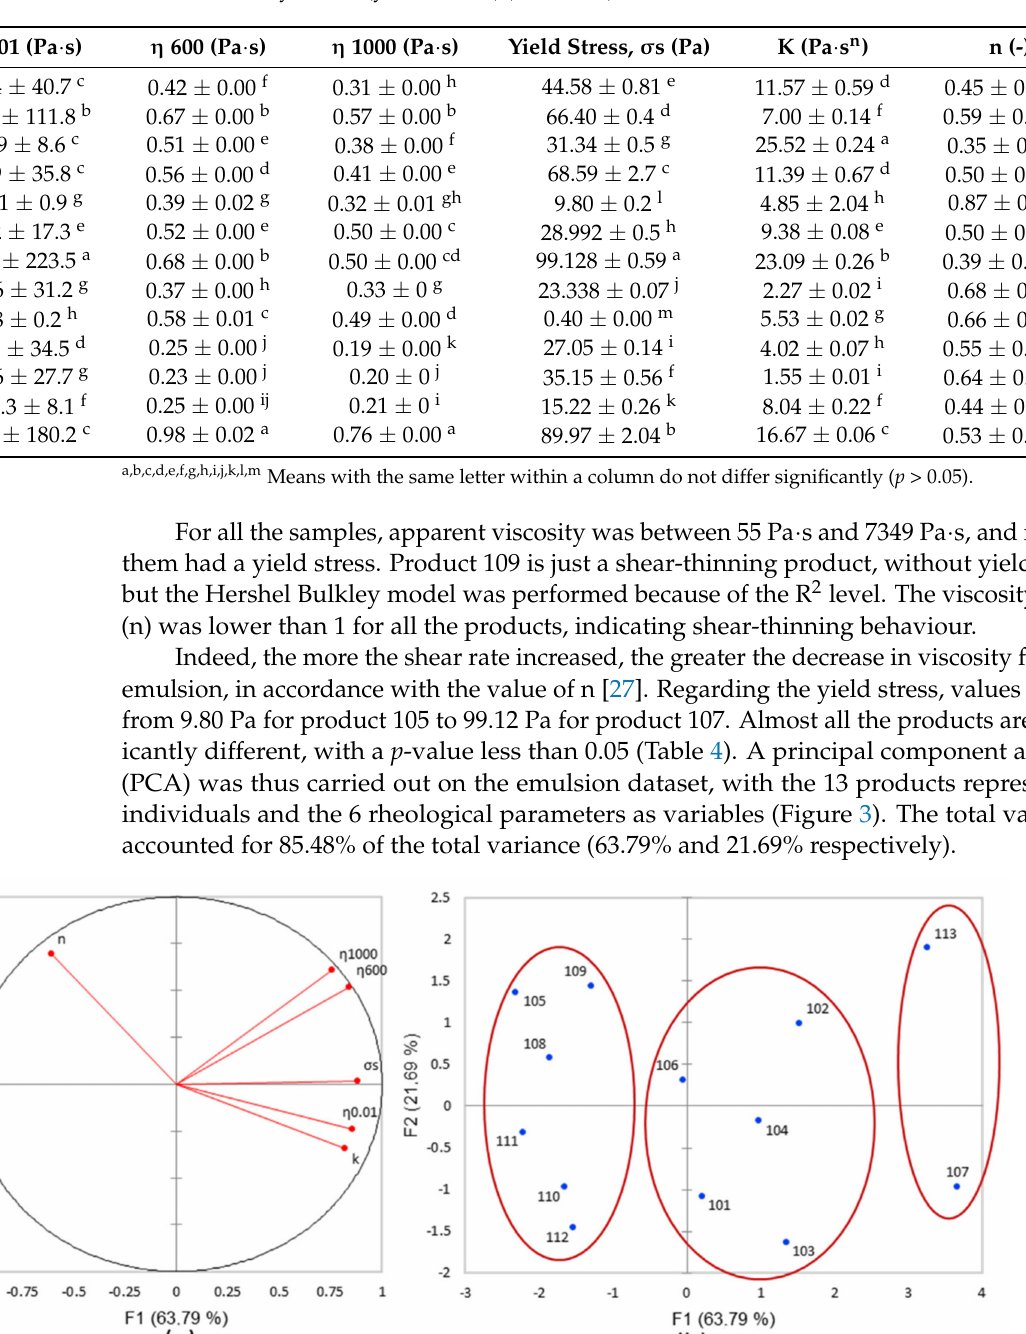
Table 4. Values of viscosity (means ± SD) obtained for 3 different shear rates (in s − 1 ) and from the Herschel Bulkley model (yield stress ( σ ), K and n).